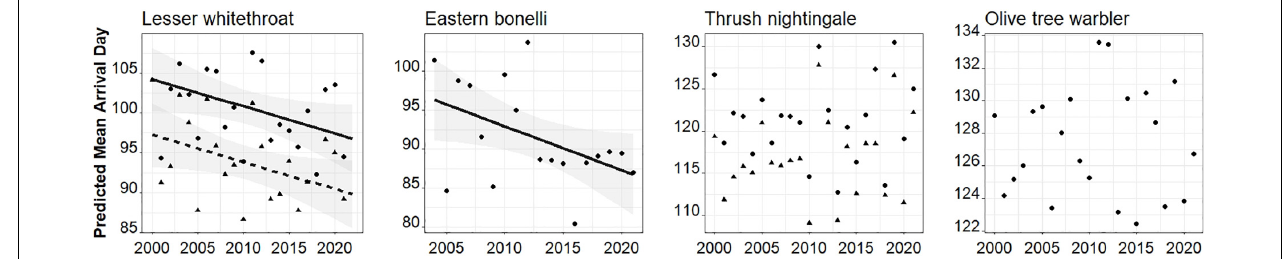
FIGURE 2 | Spring migration phenology (mean first arrival day) of the four study species migrating from wintering grounds in Africa to stopover sites in Israel across 22 years (2000–2021). Lines were fitted using GLMM and shown only where slope was significant ( P < 0.05) with confidence intervals shaded in grey. In Lesser whitethroat and Thrush nightingale data depict adults (triangles and a dashed line) and second year individuals (solid circles and a solid